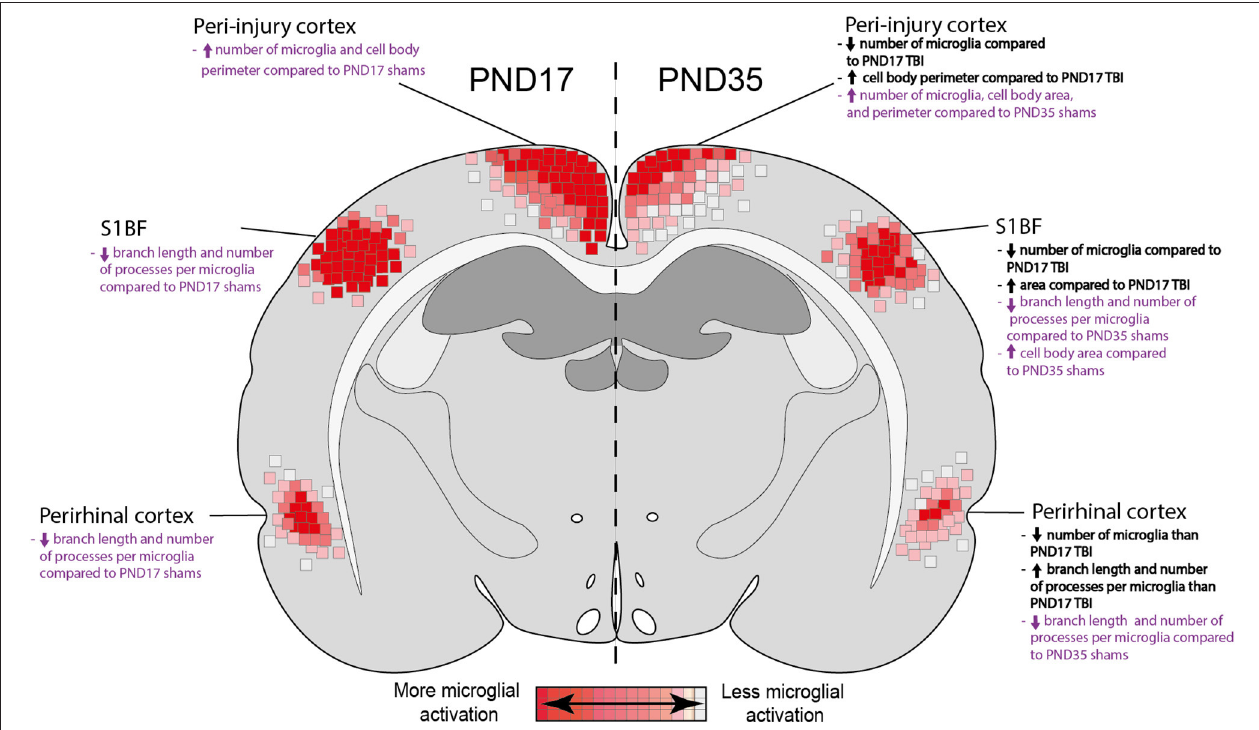
FIGURE 10 | Summary heat map of microglial activation in PND17 rats compared to PND35. Quantitative skeletal analysis was used to assess microglia morphology (number of microglia, number of microglia branches, branch processes per cell) and results are summarized in a heat map. Results in bold black text indicate differences between PND35 TBI and PND17 TBI. Results in purple text indicate differences between TBI groups and their respective shams. Overall, TBI activated microglia in both ages. Rats injured at PND35 had fewer microglia in all cortical regions of interest compared to rats injured at PND17. PND17 had more microglial activation (de-ramification) compared to rats injured at PND35, indicated by at least one measured outcome in each cortical region of